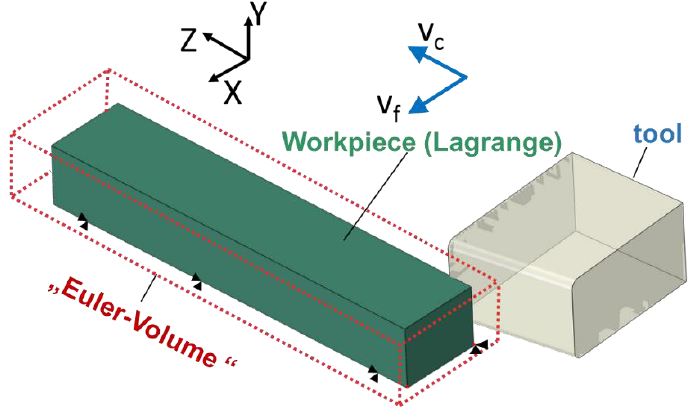
Figure 5. Schematic representation of cutting tool and workpiece.